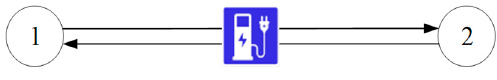
Figure 5. Representation of a FCS.